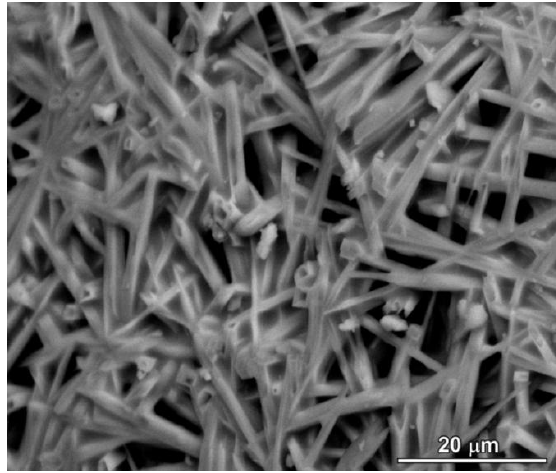
O nanoparticles and 2 3